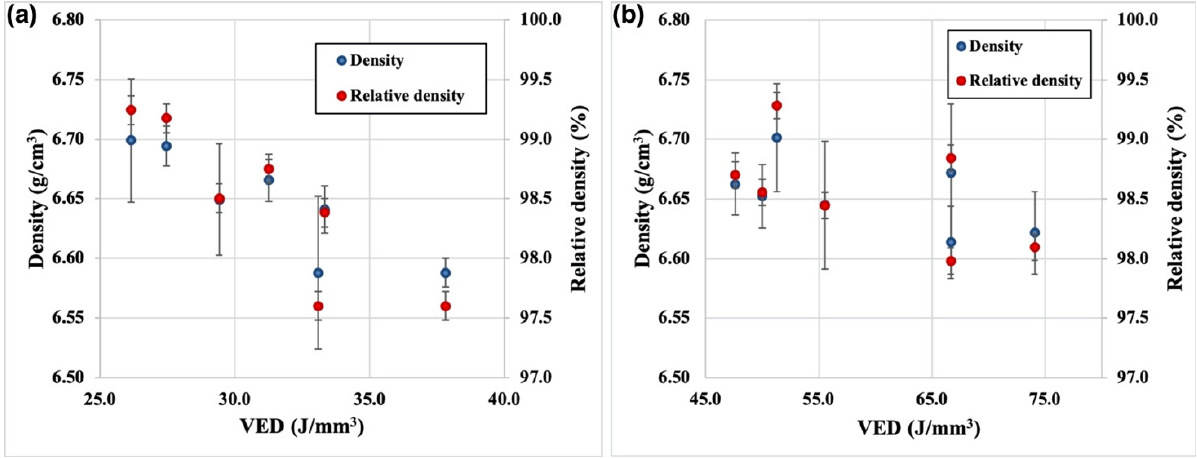
Figure 2. Effect of VED on the density of NiTiNb samples produced by SLM using ( a ) 300 µ m and ( b ) 70 µ m laser spot